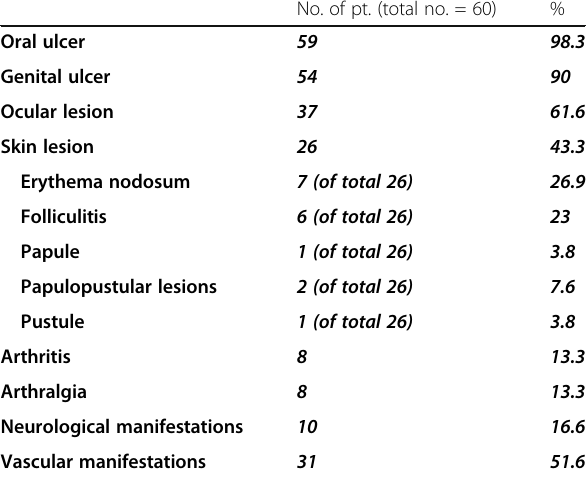
Table 3 Clinical characteristics of the studied BD patients No. of pt. (total no. = 60)